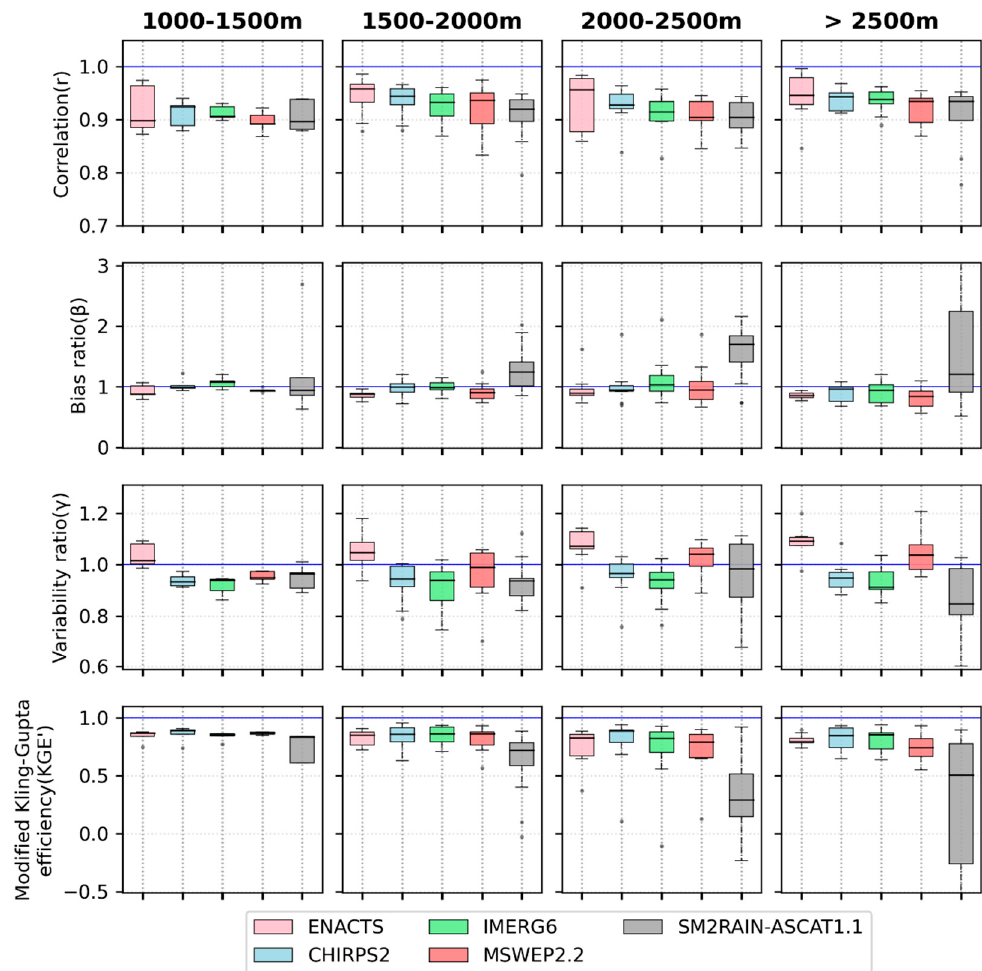
Figure 3. Boxplot of correlation (r), bias ratio ( β ), variability ratio ( γ ), and modified Kling-Gupta efficiency (KGE’) values of precipitation datasets compared to gauge observation. The horizontal blue line indicates the respective optimum score for each measure.